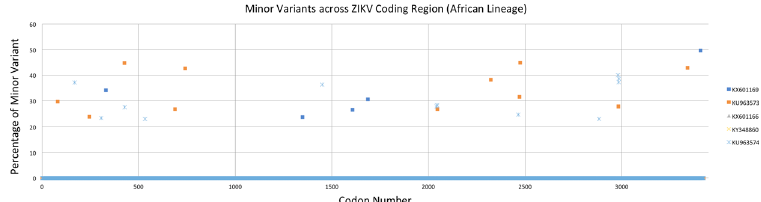
Figure 3. Positions of minor variants detected in African-lineage Zika viruses. The location of codons containing minor variants in strains belonging to the African lineage with the frequency threshold set at 20% (or more) of